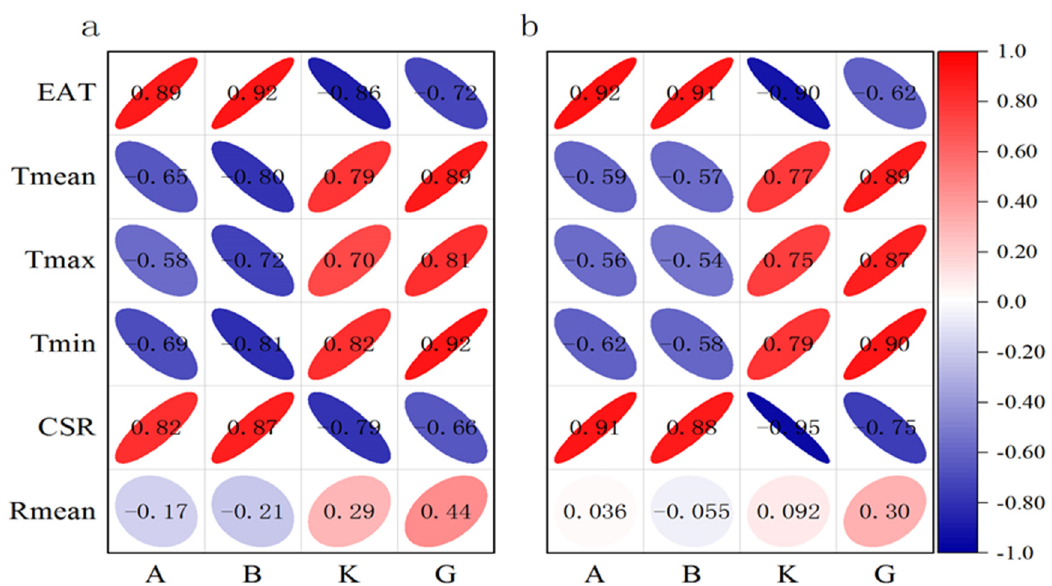
Figure 1. The correlation of temperature and radiation with filling coefficient and filling rate. ( a ):